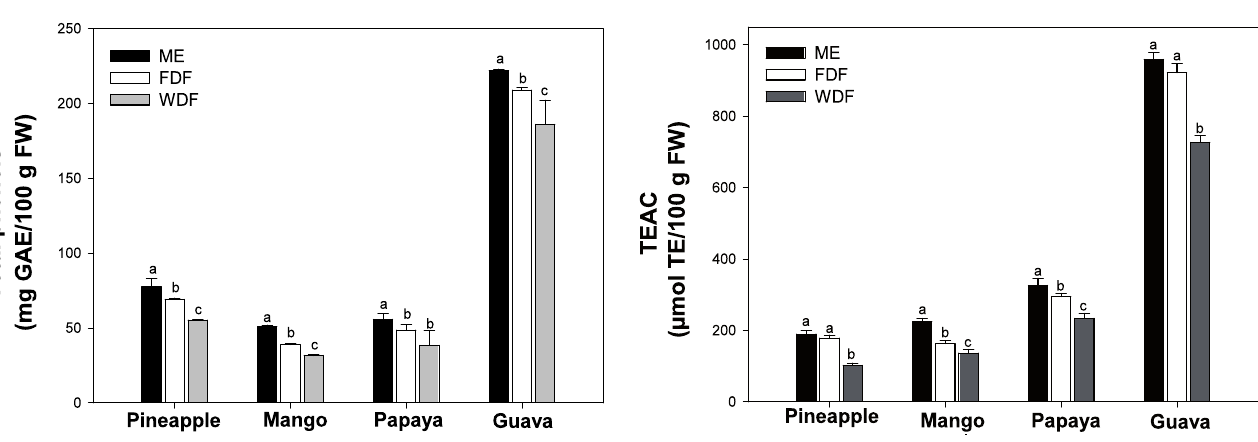
Fig. 4: Radical scavenging activity assessed by the TEAC assay, of metha- nolic extracts (ME) of tropical fruits by adding fruit dietary fiber (FDF) and wheat dietary fiber (WDF). Different letter in the same fruit indicates significant difference (p<0.05) between fiber